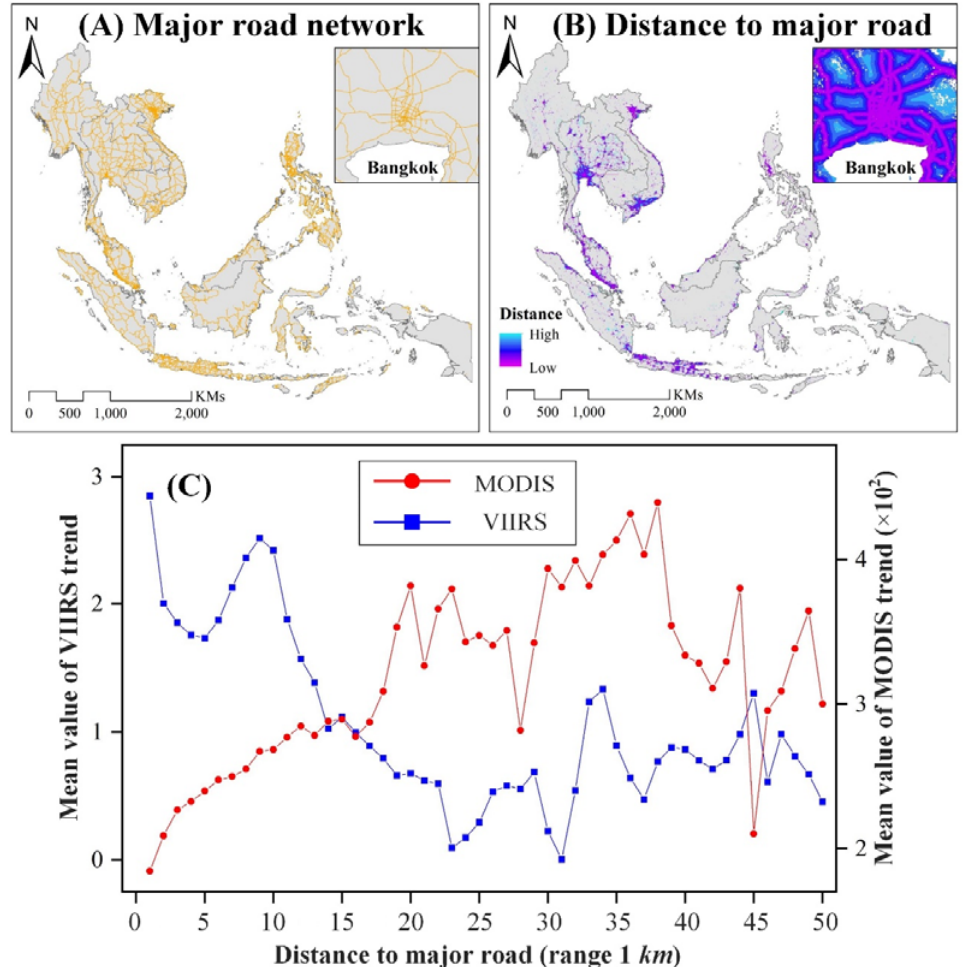
Figure 7. The spatial distribution of a major road network from OpenStreetMap in the Southeast Asia (SEA) region ( A ) and distance from VIIRS change grids (grids count: ≈ 1.85×10 6 ) to major roads ( B ). ( C ) Mean value of VIIRS/DNB and MODIS/NDVI overall trends under different distance (kilometers, KMs) to the nearest major